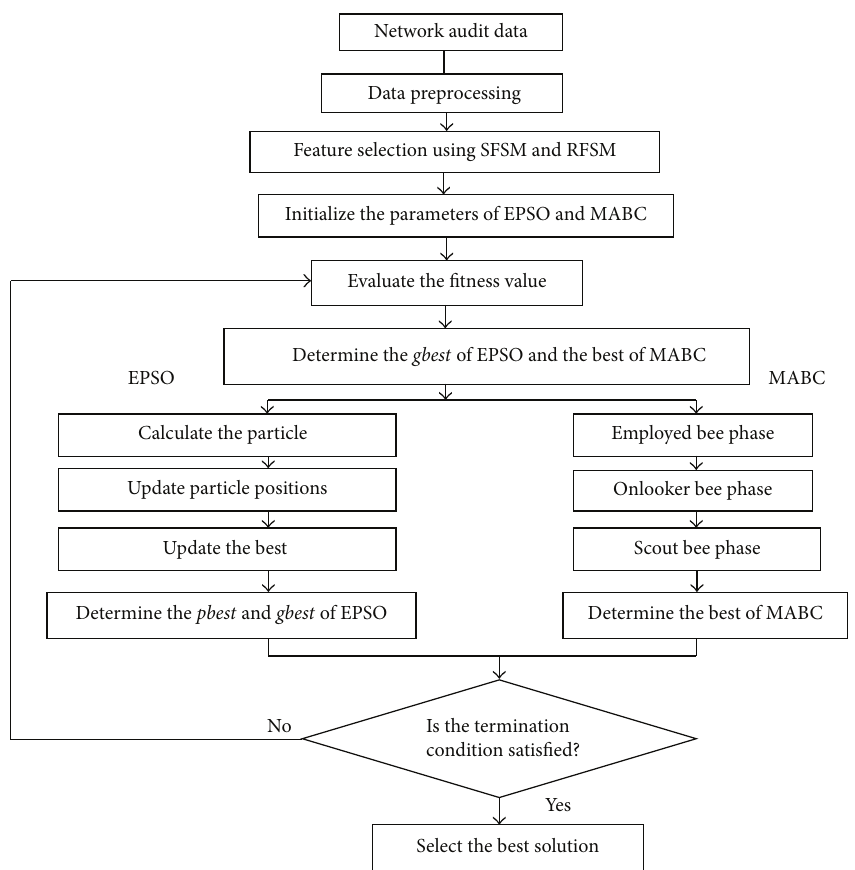
Figure 2: Flowchart of the proposed hybrid MABC-EPSO